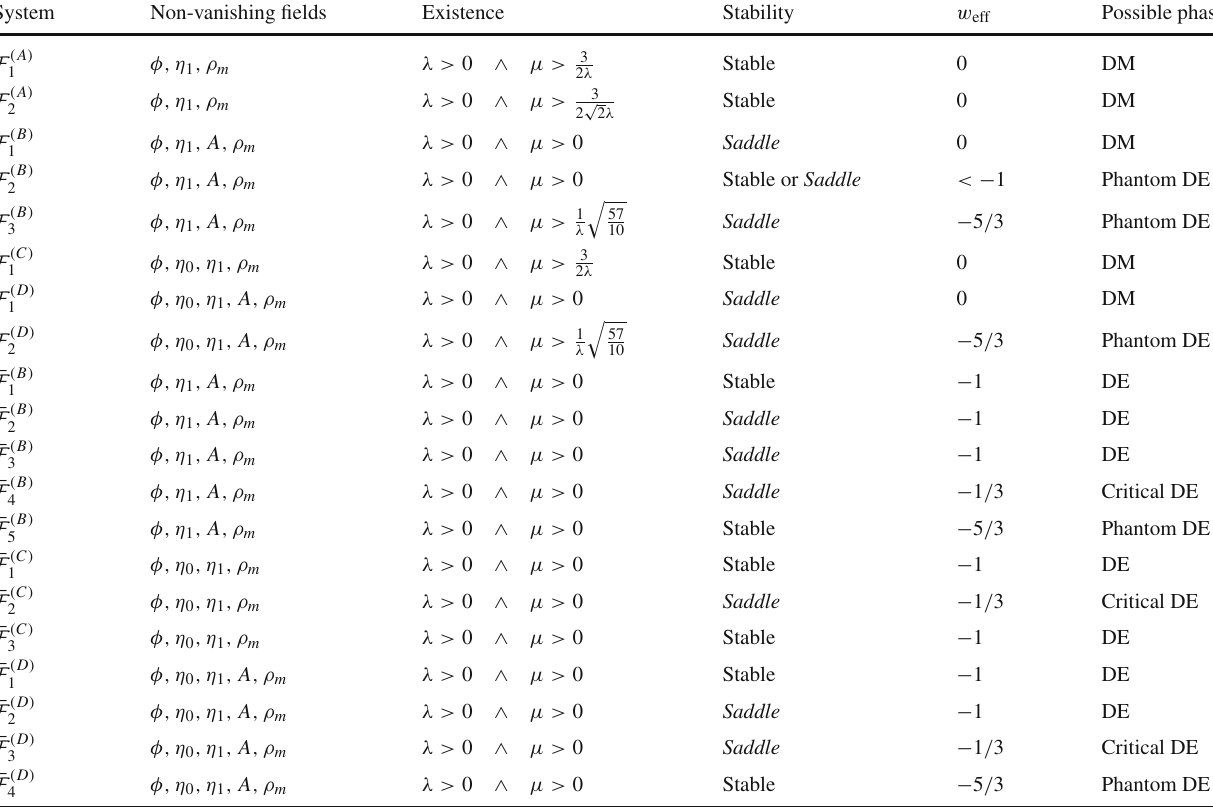
Table 1 The table summarises non-vanishing fields, effective equation of state and possible phases of the universe for each system. Noted that ¯ F i are the systems with the slow-roll approximation, ˙ η i = 0 System Non-vanishing fields Existence